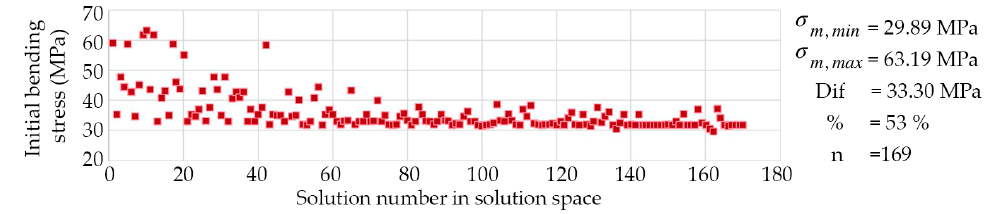
Figure 21. Evolution of initial bending stress for 75 × 30 mm 2 cross-section in Step 2.